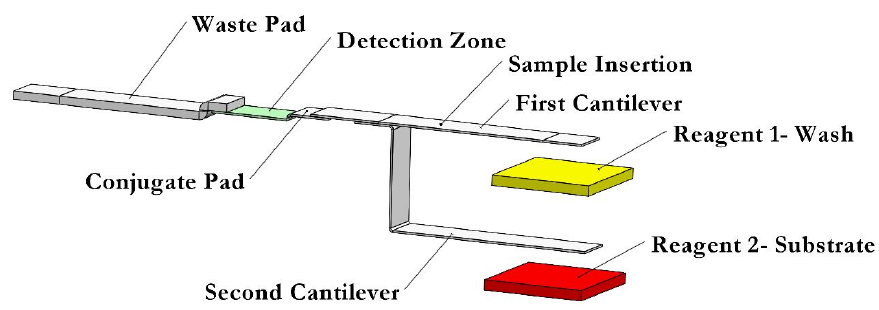
Figure 1. A schematic of the proposed dual B-MaCs assembly for performing an